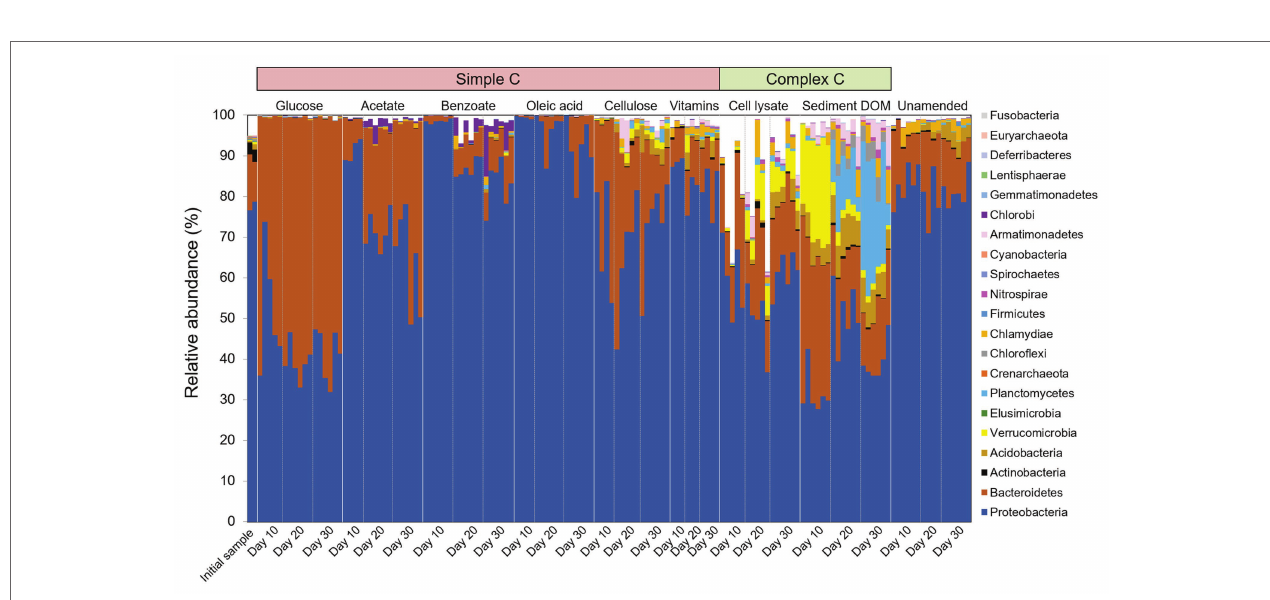
FIGURE 3 | Temporal community structures of the initial groundwater sample and different C-amended enrichments reported as relative abundance of taxonomic phyla over three sampling timepoints (Days 10, 20, and 30). Bar plots that do not sum to 100% indicate the remaining OTUs did not affiliate with a known phylum per SILVA taxonomic